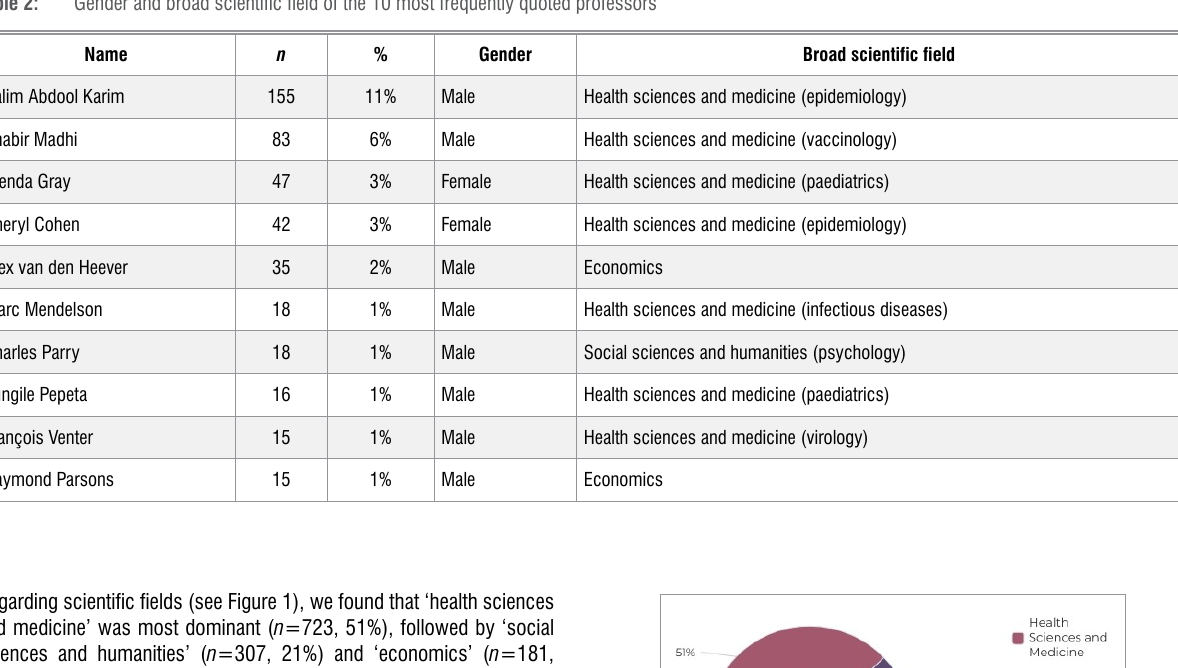
Gender and broad scientific field of the 10 most frequently quoted